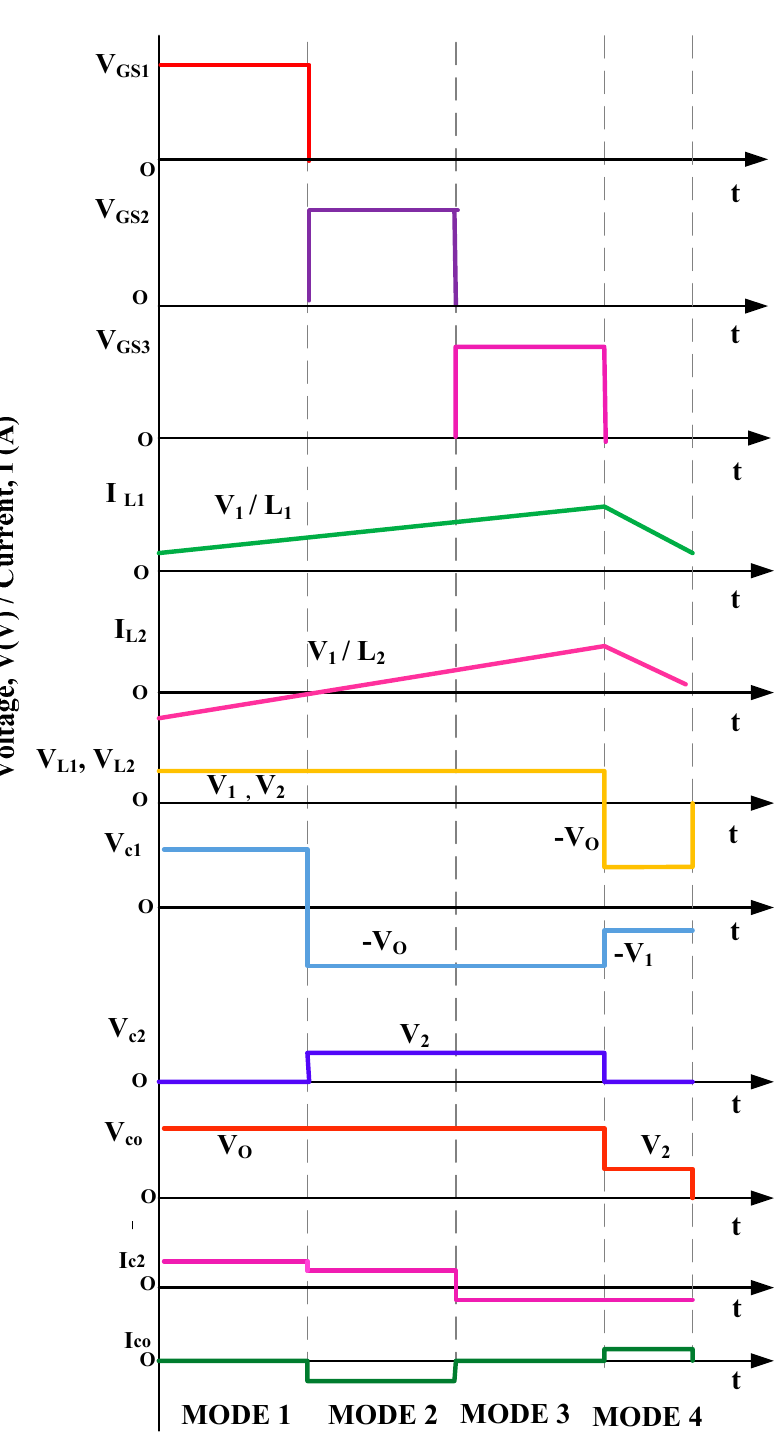
Figure 4. Key waveforms of the proposed converter. The circuit diagrams under different operating modes in unidirectional topology (i) Mode 1 (S 1 is ON and S 2 , S 3 are OFF): In this mode, the switch S 1 is turned on and switches S 2 and S 3 were turned off. Both the sources V 1 and V 2 were supplying the multiport converter. The inductors L 1 and L 2 were charged to the value of input voltage V 1 . The current through L 1 increased linearly to a value V 1 /L 1 . The capacitor C 1 was charged equal to V o , which was the output voltage of the converter. Diode D 1 was reverse biased and diodes D 2 and D 3 were forward biased.